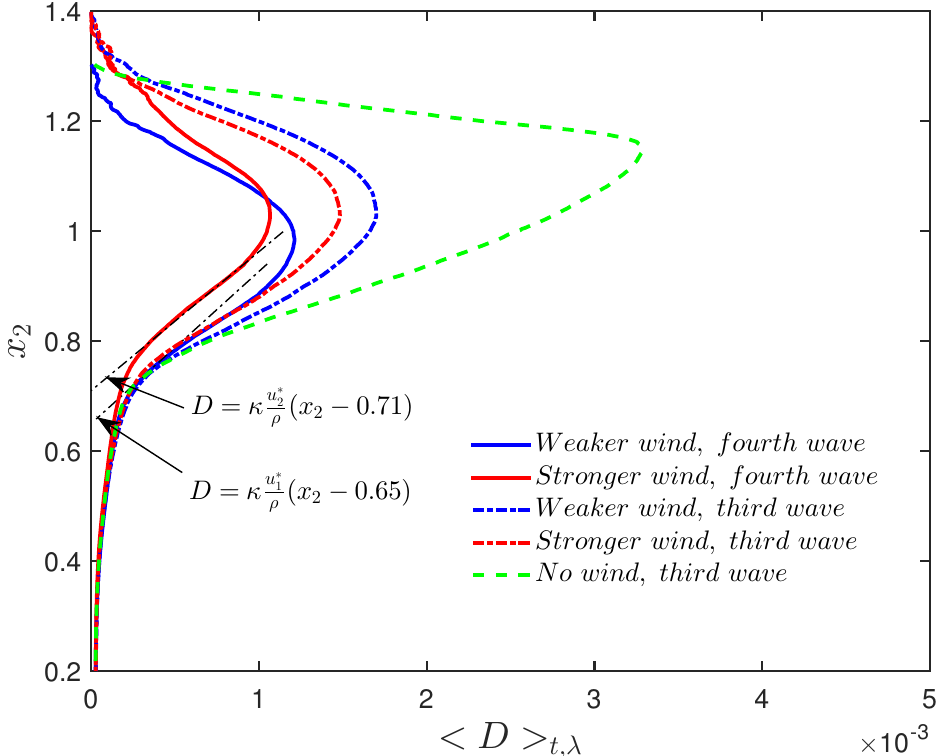
Figure 10. Vertical profile of streamwise-time averaged eddy diffusivity [m 2 /s] for the case with wind body force f = 0.5 [N/M] (blue labeled as “Weaker wind”), the case with the wind body force f = 0.6 [N/M] (red labeled as “Stronger wind”) and the case with no wind stress and with non-breaking